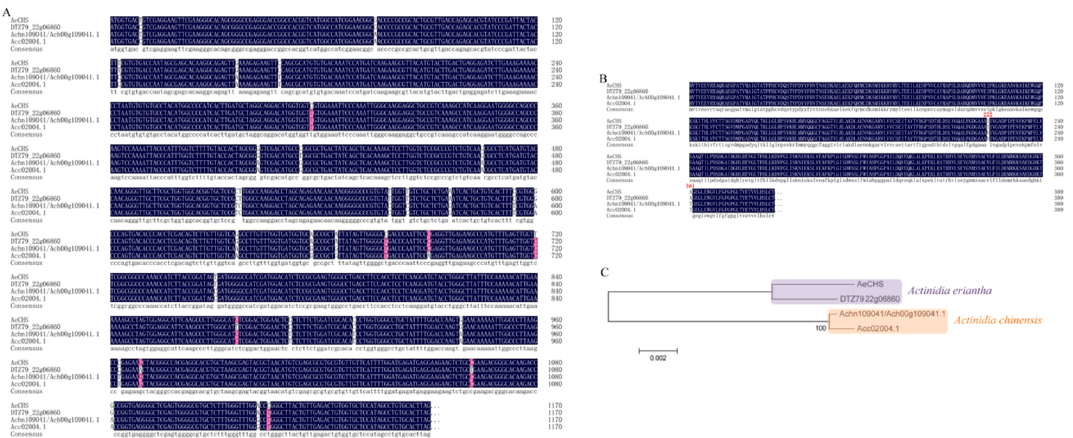
Figure 5. Sequence alignments of DNA and protein, and construction of phylogenetic tree. ( A ) DNA sequence alignment of CHS in di ff erent Actinidia species and cultivars. ( B ) Protein sequence alignment of CHS in di ff erent Actinidia species and cultivars. ( C ) Construction of the phylogenetic tree based on amino acid sequences. AeCHS , the complete coding sequence was identified and cloned from Actinidia eriantha ‘Zaoxu’ petals. DTZ79_22g06860, gene ID of CHS in Actinidia eriantha ‘White’; Achn109041 / Ach00g109041.1, Gene ID of CHS in Actinidia chinensis ‘Hongyang’; Acc02004.1, Gene ID of CHS in Actinidia chinensis ‘Red 5 ′ .